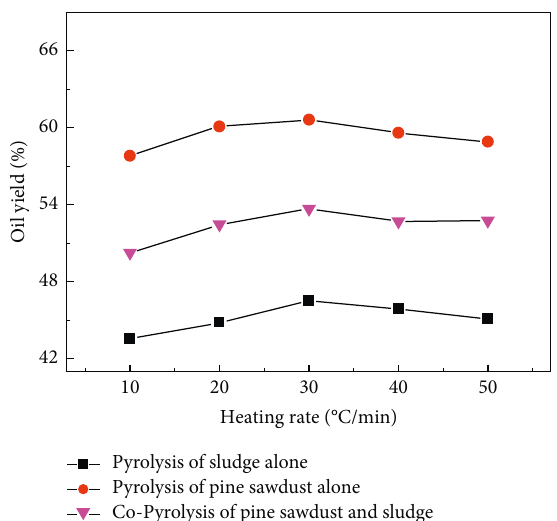
Figure 4: Influence of heating rate on fixed-bed pyrolysis process.